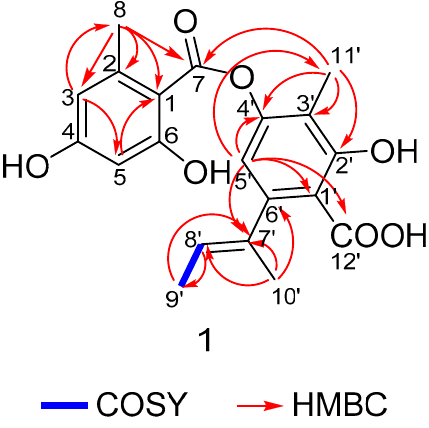
Figure 2. Key COSY (bold line) and HMBC (arrow) correlations of compound 1 . Molecules 2018 , 23 , x FOR PEER REVIEW